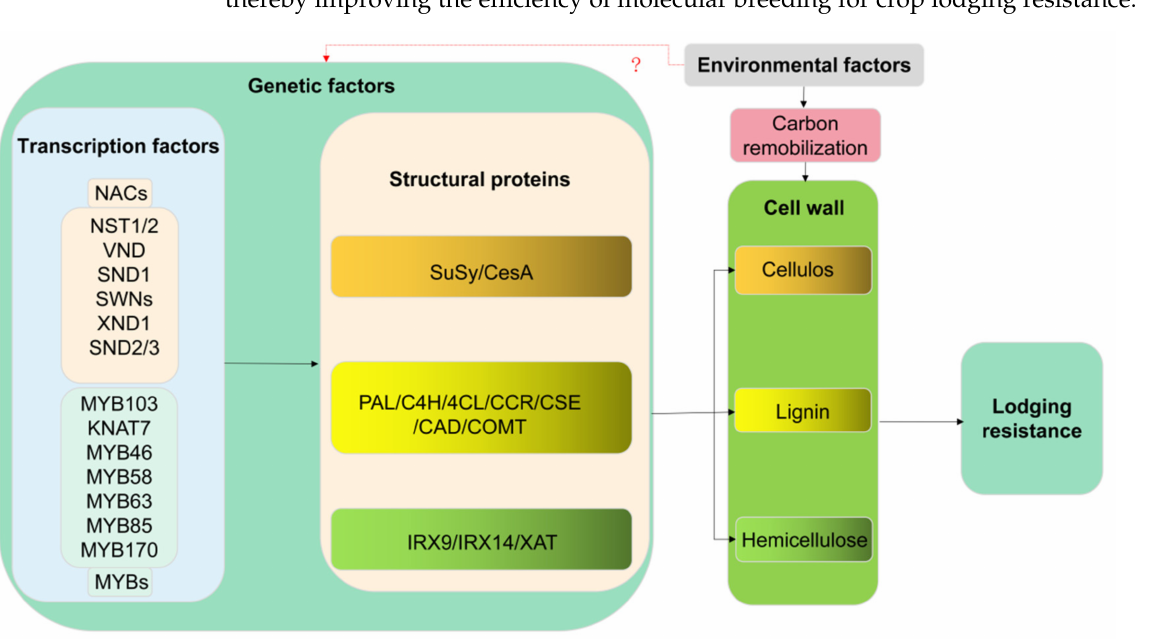
mark indicates that the interaction between environmental factors and genetic factors in the study of lodging resistance mechanism needs to be further